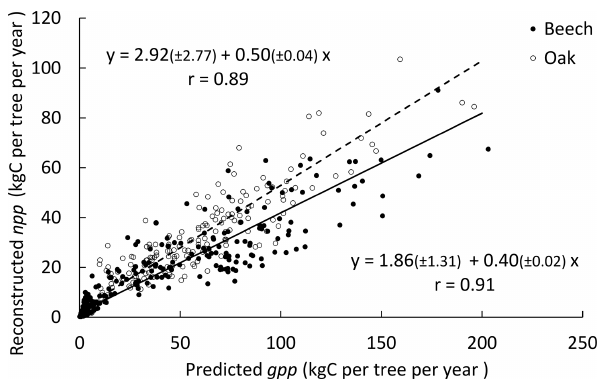
Figure 2. Relationship between the individual npp reconstructed based on successive stand inventories (2001 and 2011) and the gpp predicted with the process-based option (photosynthesis method of CASTANEA) for the three stands. Values in parentheses are 95% confidence intervals for the intercept and the slope in the equations. The Pearson’s correlation between npp and gpp is indicated on the